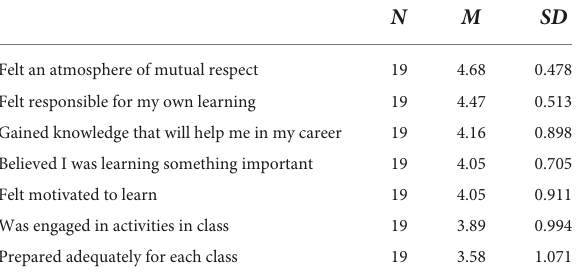
TABLE 7 Student mean ratings of the degree to which each statement reflects their participation in class (5-point Likert scale, where 5 is “a great deal” and 1 is “none at